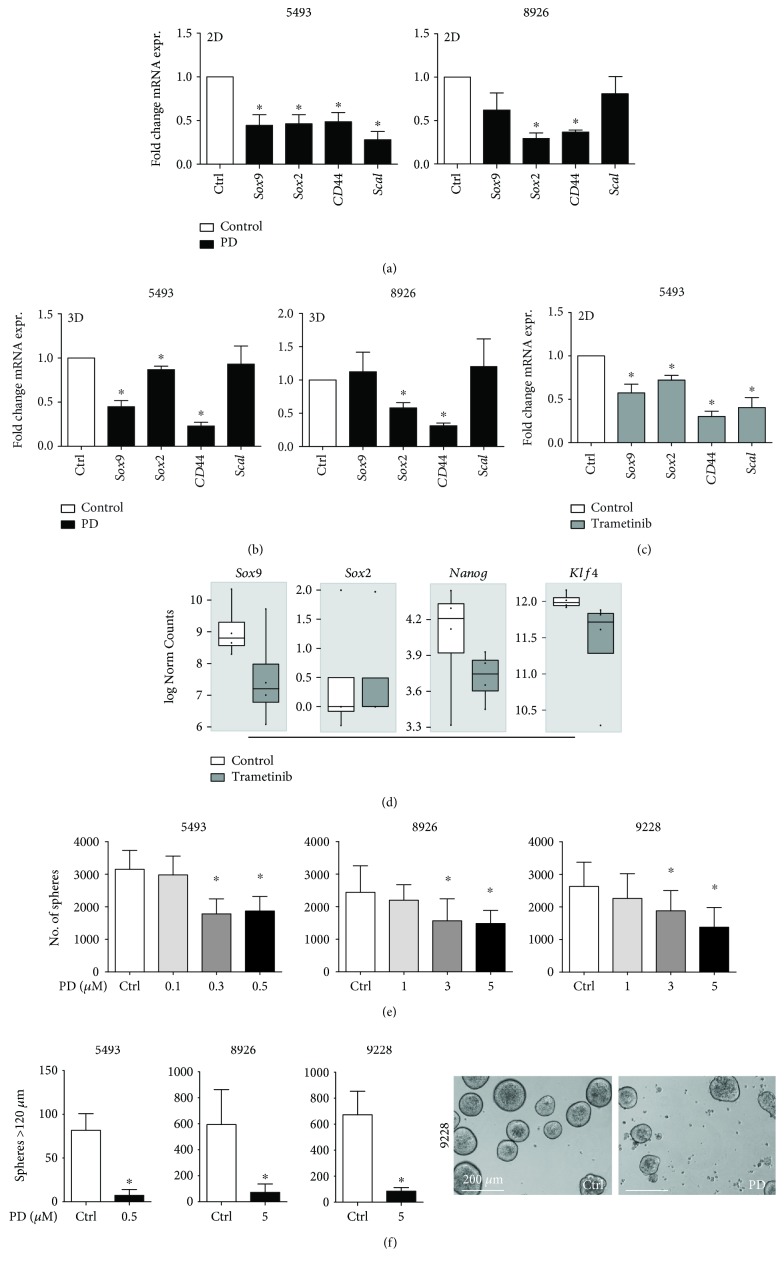
Effects of MEK inhibition on stemness. Gene expression of the indicated stemness-associated genes in (a) adherent cultures or (b) spheres after treatment with vehicle or PD0325901 (PD). (c) Gene expression and (d) RNAseq analysis of murine primary cancer cell lines treated with DMSO vehicle (white) or trametinib (grey) for 48 h. (e) Sphere formation capacity of cells pretreated with PD0325901 at the indicated concentrations. (f) Quantification of large spheres (>120 μm) and representative micrographs of sphere cultures after 7 days. n ≥ 3 for all experiments. ∗
P < 0.05 vs. control.